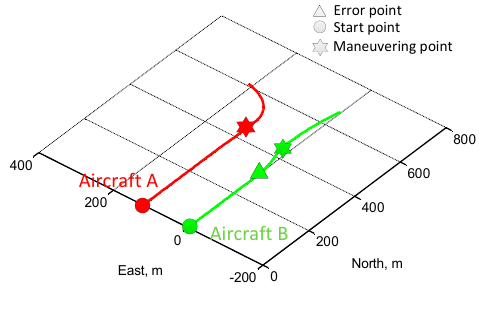
Figure 10. 2D flight path.